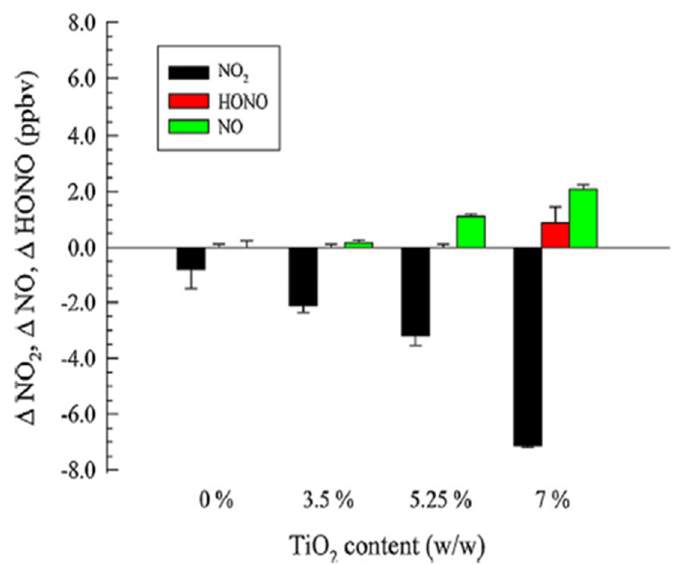
Figure 8. Formation of NO 2 , NO, and HONO on photocatalytic paints with 0%, 3.5%, 5.25%, and 7% of TiO 2 NPs (NO 2 mixing ratio of 40 ppb and RH of 40%) [129] .